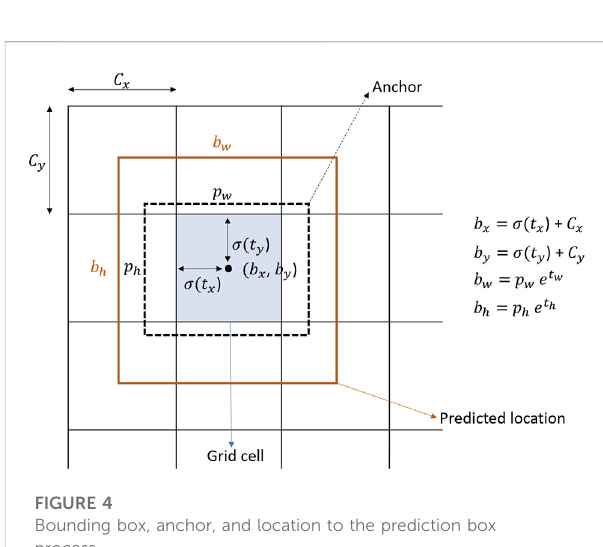
FIGURE 4 Bounding box, anchor, and location to the prediction box